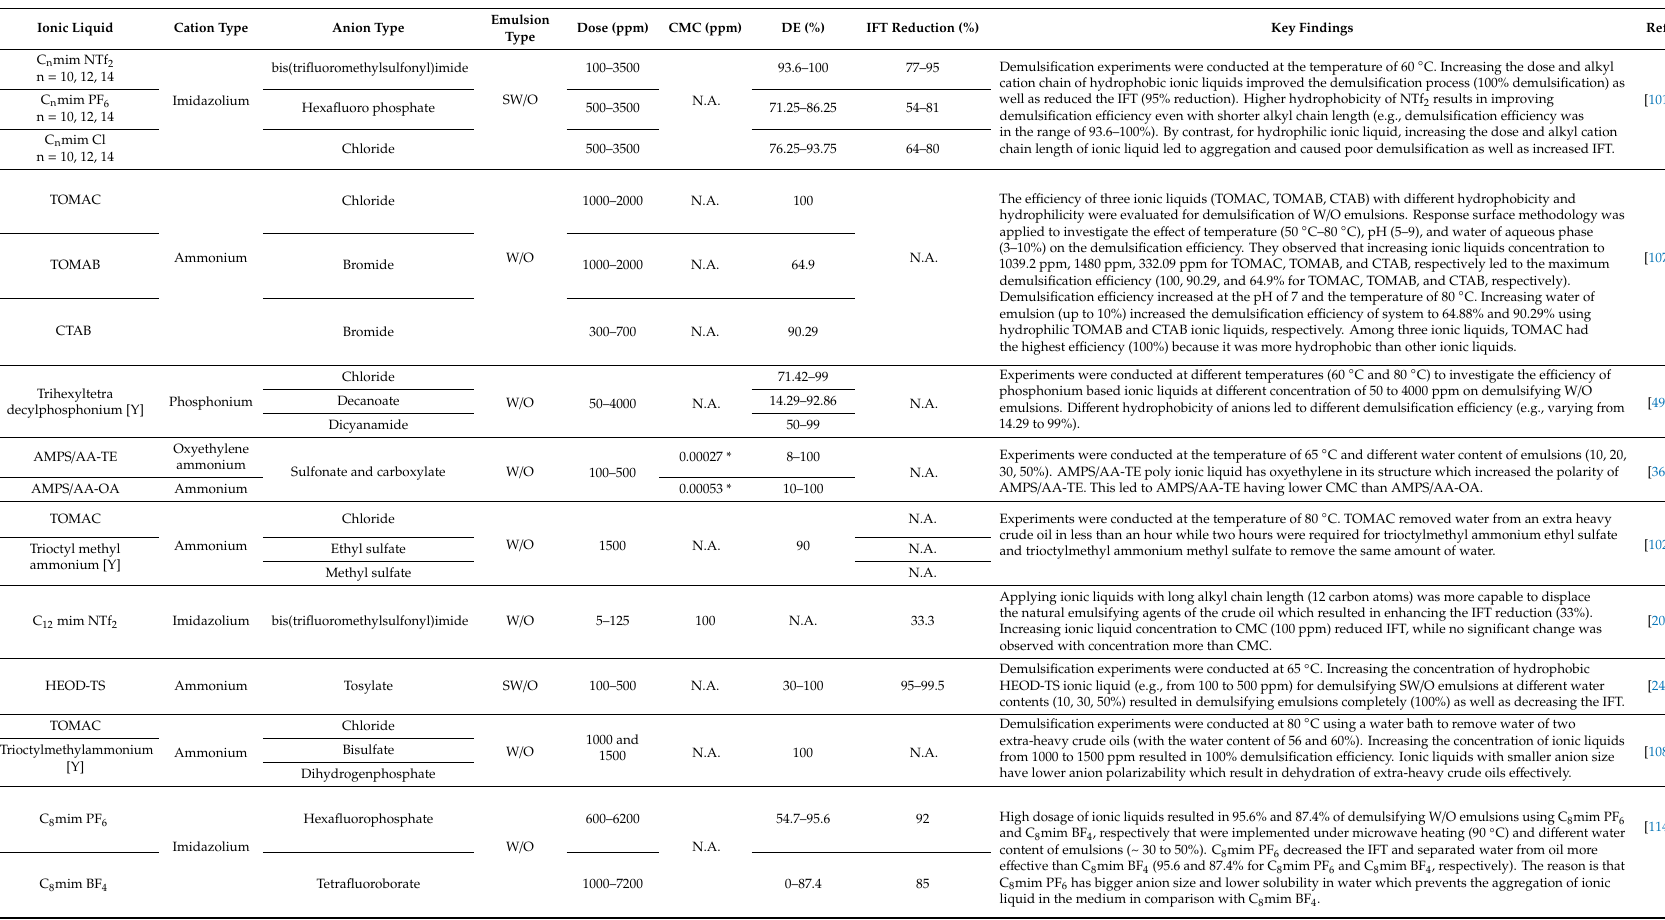
Table 4. List of application of ionic liquids as